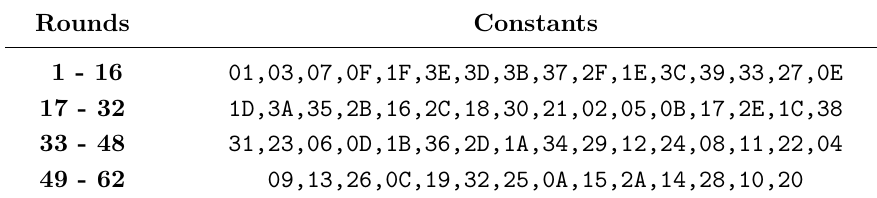
Table 2: SKINNY Round Constants.